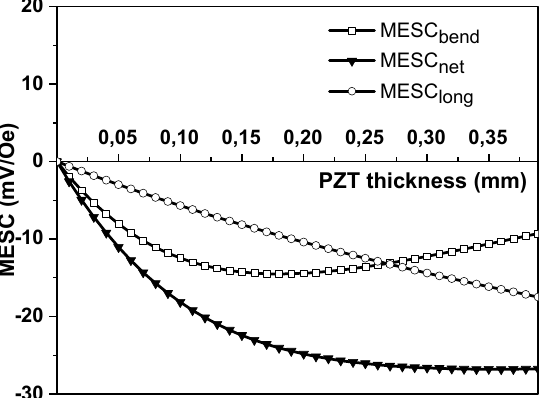
Figure 5. Estimated dependence of MESC in a Ni-Metglas-PZT second-type three-layered structure on the PZT layer thickness. The Ni layer thickness t m 1 = 0.2 mm, the Metglas thickness t m 2 = 0.2 mm.